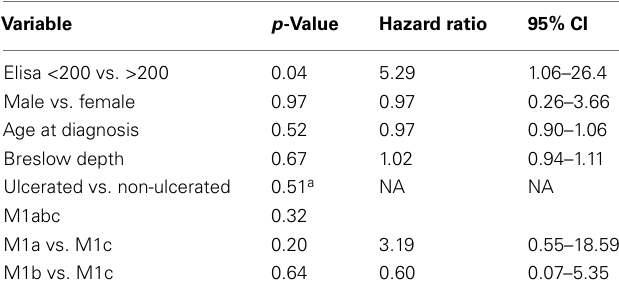
Table 2 | Demographics of 11 melanoma patients not treated with ipilimumab .